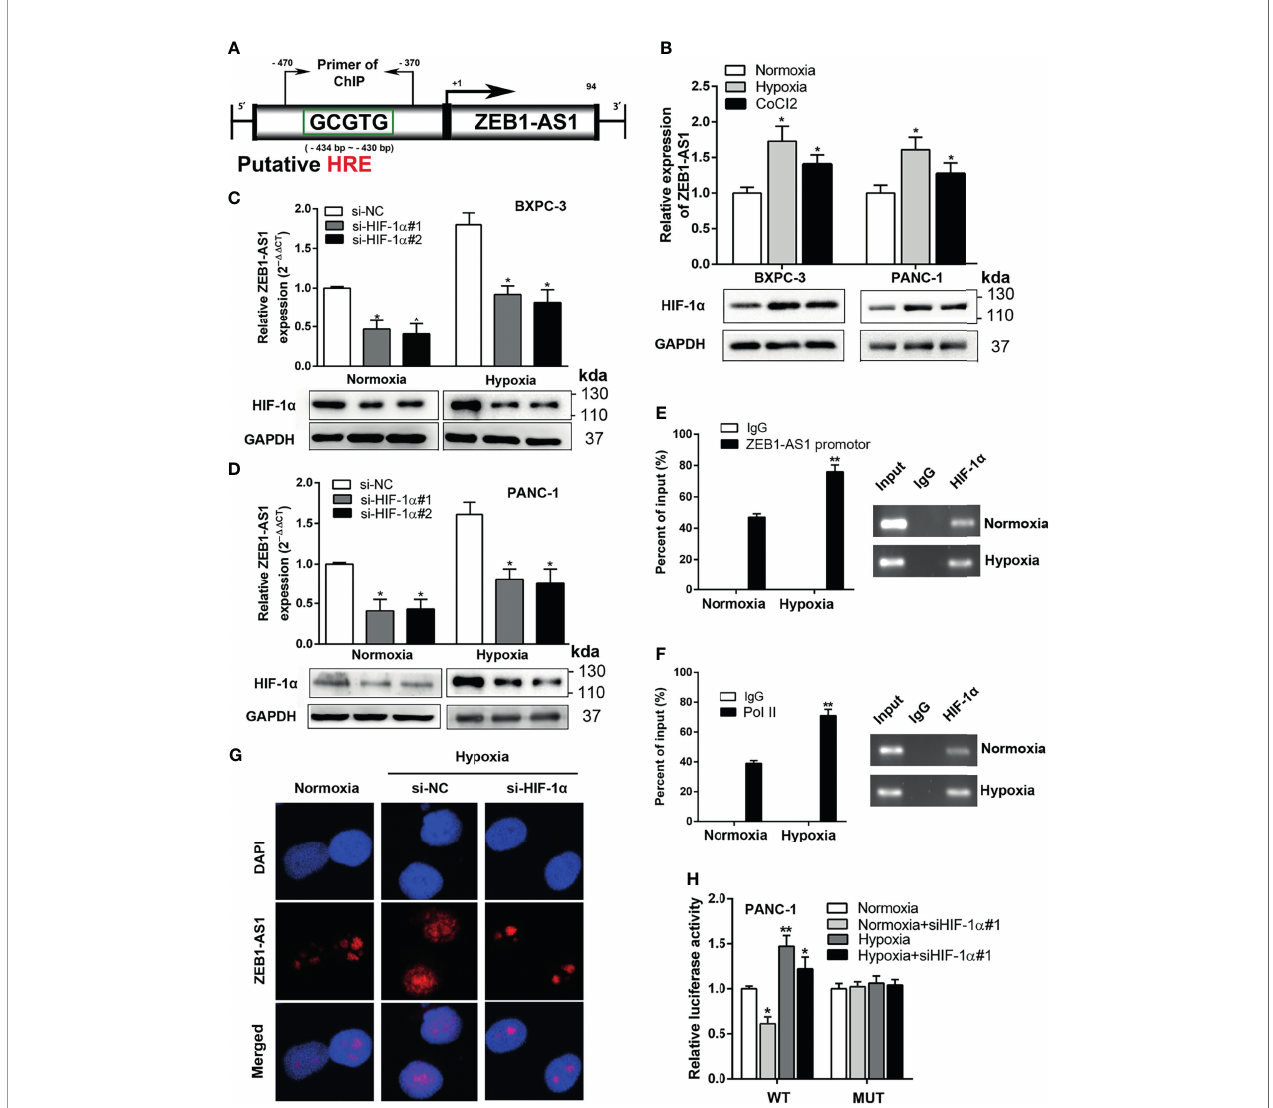
FIGURE 4 | ZEB-1AS1 transcription is regulated by HIF-1 a during hypoxia medium. (A) A putative hypoxia-responsive element (HRE) was found in the promoter region of ZEB1-AS1. (B) The expression levels of ZEB1-AS1 (upper) and HIF-1 a protein (lower) in BXPC-3/PANC-1 cells were measured after being cultured during normoxia, hypoxia (1%O2), or CoCl2 (concentration of 100 µM under 48 h) at the mRNA and protein levels by qRT-PCR and Western blot analysis, respectively. (C, D) After knockdown of HIF-1 a with siRNA, the expression of ZEB1-AS1 was evaluated by qRT-PCR in BXPC-3 and PANC-1 cells under normoxia or hypoxia (upper). Lower diagrams indicated HIF-1 a protein levels by Western blot analysis. (E) ChIP assays with anti-HIF-1 a antibody were performed to af fi rm the binding between HIF-1 a and HRE of ZEB1-AS1 promoter region in PANC-1 cells under normoxia or hypoxia condition. (F) After being cultured in hypoxia or normoxia, ChIP assays with anti-Pol II antibody were performed to ascertain the binding capacity between Pol II and ZEB1-AS1 promoter region in PANC-1 cells. (G) After knockdown of HIF-1 a , the expression of ZEB1-AS1 was shown by FISH assays in PANC-1 cells during normoxia and hypoxia condition. (H) Wild-type ZEB1-AS1 promoter-containing pGL3 reporter vector (WT) or mutant-type ZEB1-AS1 promoter-containing pGL3 reporter vector (MUT) of ZEB1-AS1 promoter sequence fi re fl y luciferase reporter activity in PANC-1 cells transfected with siNC or siHIF-1 a and cultured under normoxia or hypoxia conditions were assessed by Renilla luciferase reporter assays after 48 h All data were presented as means ± SD of at least three independent experiments. Values are signi fi cant at *p ≤ 0.05 and **p ≤ 0.01 as